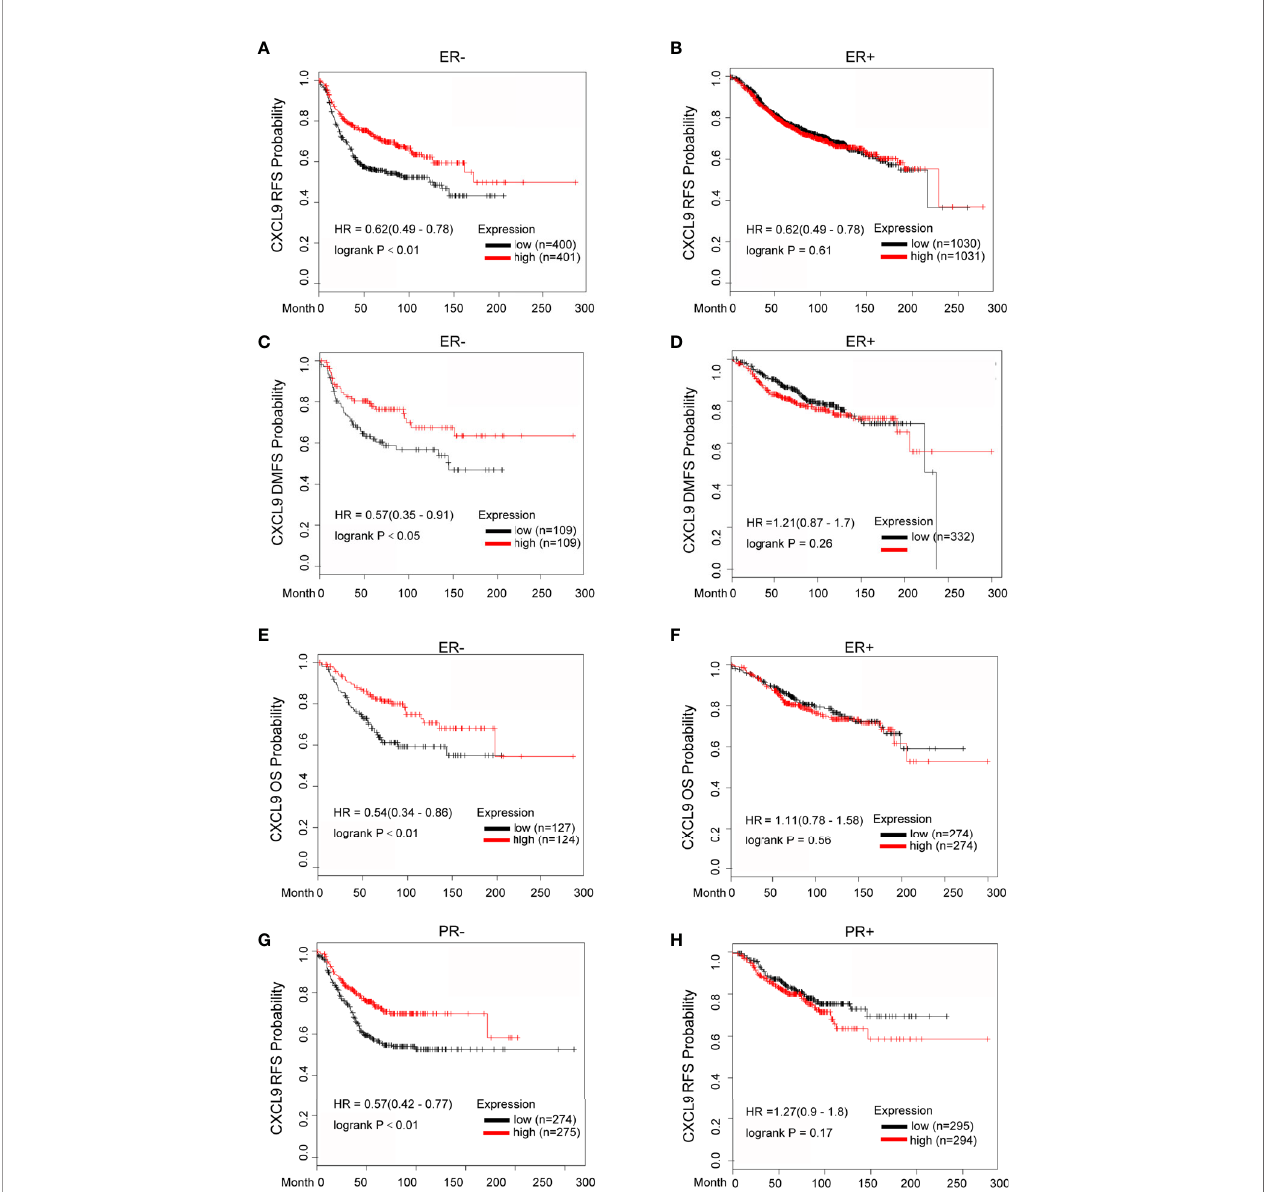
FIGURE 4 | Elevated CXCL9 expression predicted favorable survival in distinct subtypes of breast cancer patients. (A – F) Recurrence free survival (A, B) , distance metastasis free survival (C, D) , Overall survival (E, F) estimates for CXCL9 mRNA levels in ER negative and ER positive subgroup BC patients. (G, H) Recurrence free survival estimates for CXCL9 mRNA levels in PR negative (G) and PR positive (H) subgroup BC